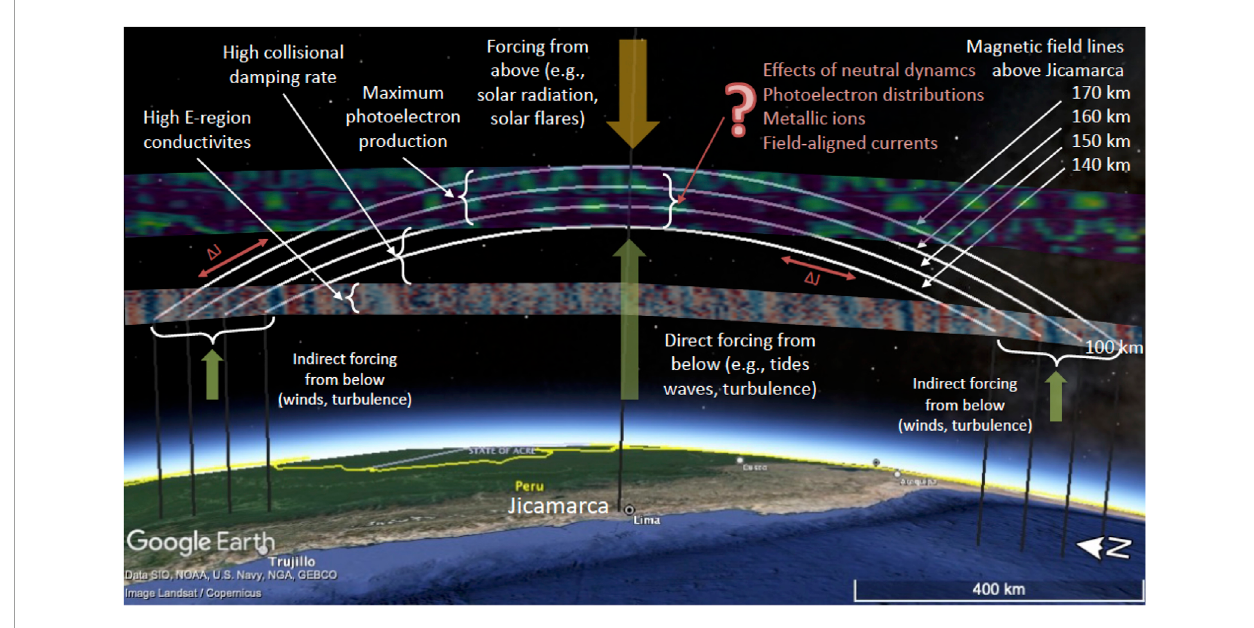
FIGURE 14 North-South sketch of 150-km geometry over Jicamarca. Magnetic field lines connecting altitudes of 140,150, 160, 170 km over Jicamarca to 100 km to the north and south, are indicated. The highly conducting daytime E region and the 150-km region are shaded with different patterns. Text in red indicate potentially missing parameters to understand remaining features of 150-km echoes (adapted from Reyes, 2017, Figure